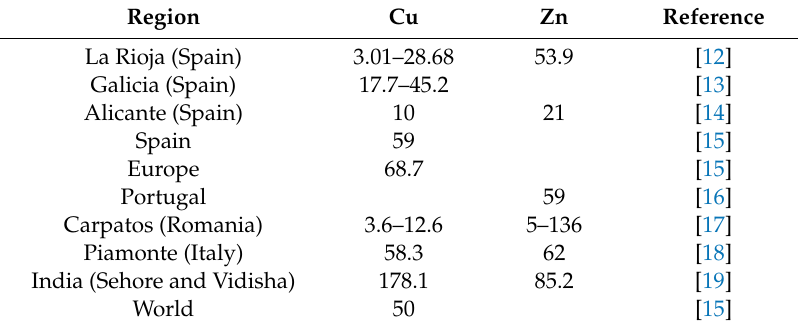
Table 2. Concentrations of Cu and Zn (average values) cited by other studies given in mg kg − 1 .